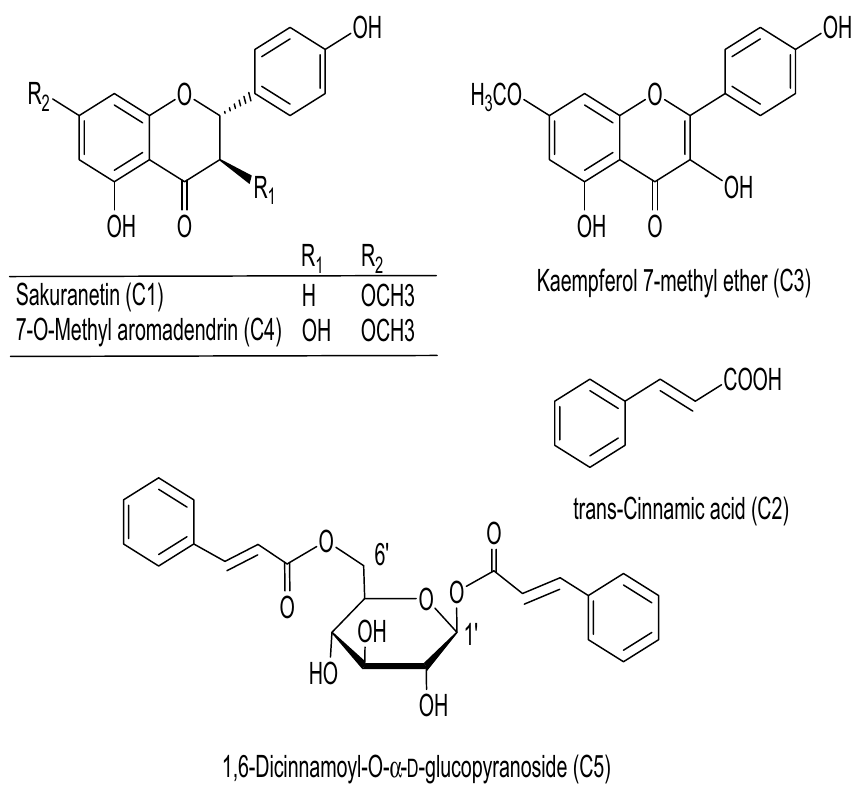
Figure 1. Chemical structures of compounds isolated from E. maculata